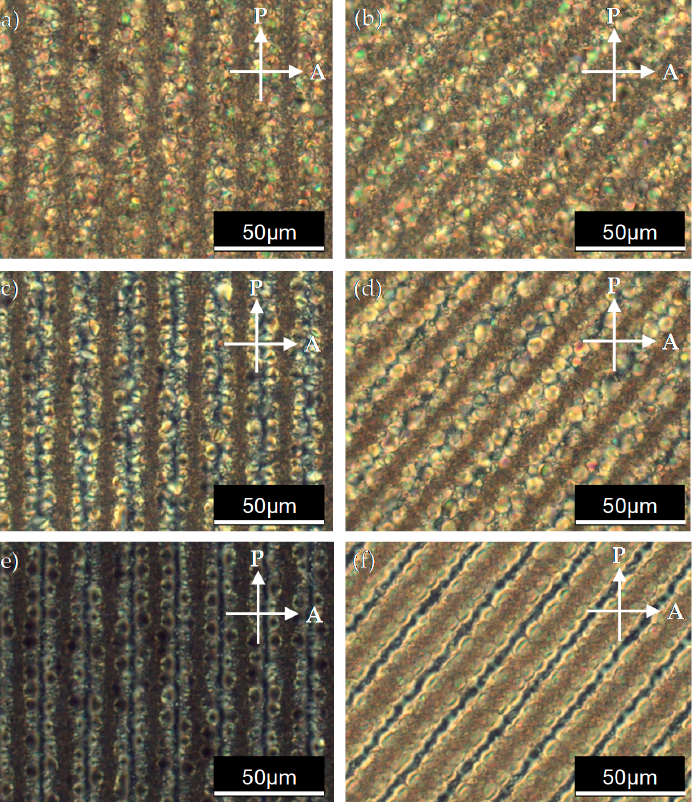
Figure 4. The POM images of the PDLC cell with the IPS electrode are shown at the applied voltage of ( a , b ) 0 V, ( c , d ) 50 V, and ( e , f ) 100 V. P and A denote the transmission axes of the polarizer and the analyzer, respectively. The direction of the IPS electrode stripes in the images on the left is parallel to the polarizer. The direction of the IPS electrode stripes on the right is at an angle of 45 ° with the polarizer.